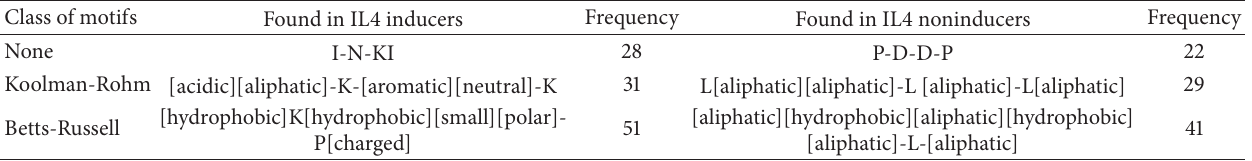
Table 2: Frequency of best motifs discovered using MERCI software in IL4 inducers and IL4 noninducers. Class of motifs Found in IL4 inducers Frequency Found in IL4 noninducers Frequency